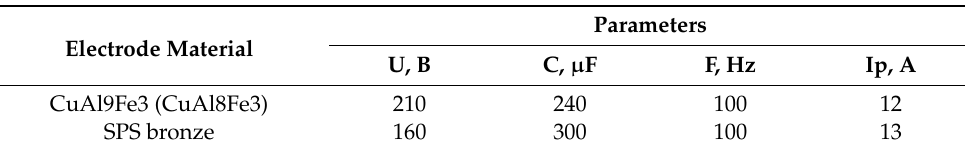
Table 4. Electrospark treatment modes of steel disc samples with bronze electrodes of CuAl9Fe3 (CuAl8Fe3) and bronze